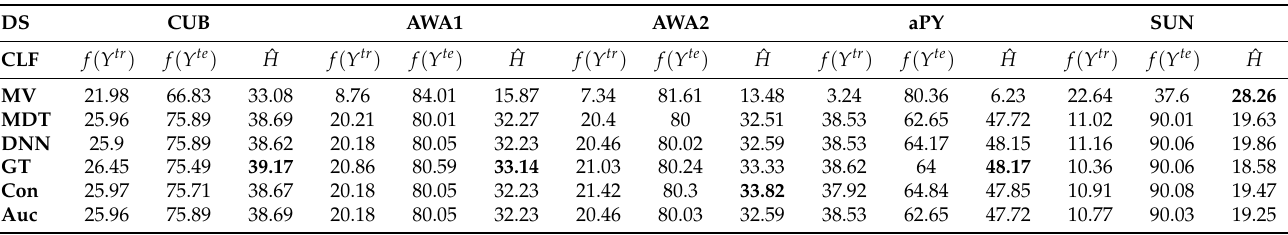
Table 9. Meta-Classifier Results for the T1